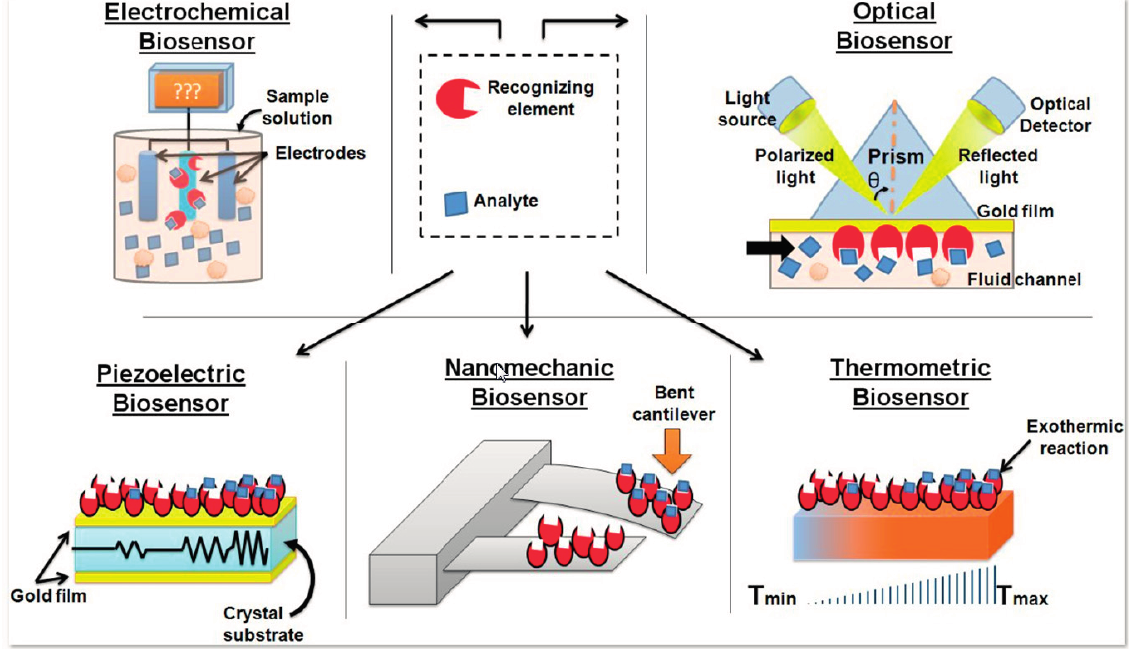
Figure 4. Generic function of several types of biosensor